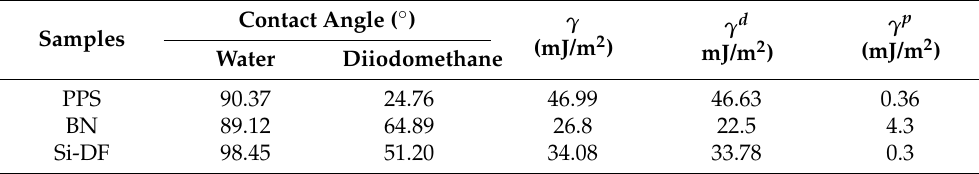
Table 2. Contact angles and surface energies of PPS, BN and Si-DF.